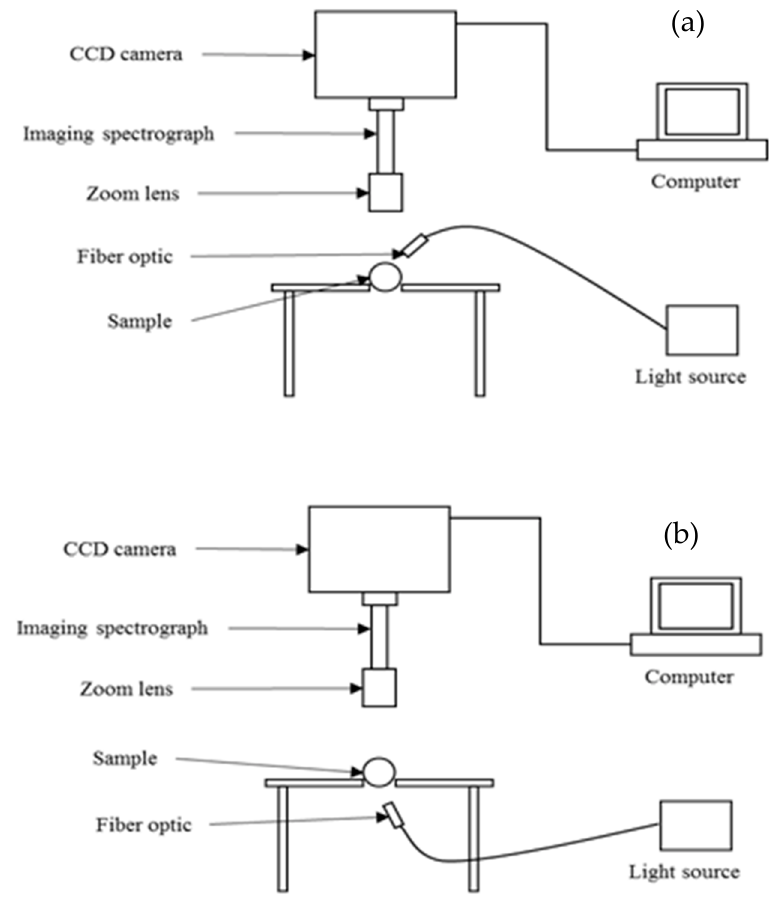
Figure 3. Schematic diagrams of hyperspectral imaging set-up in: ( a ) reflectance mode and ( b ) transmittance mode [31] .